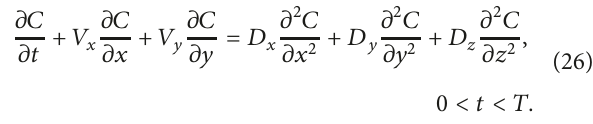
independent of height since all contour plots on 𝑧 = 0, 𝑧 = 0.2, . . . , 𝑧 = 1 are the same as Figure 2 right. The